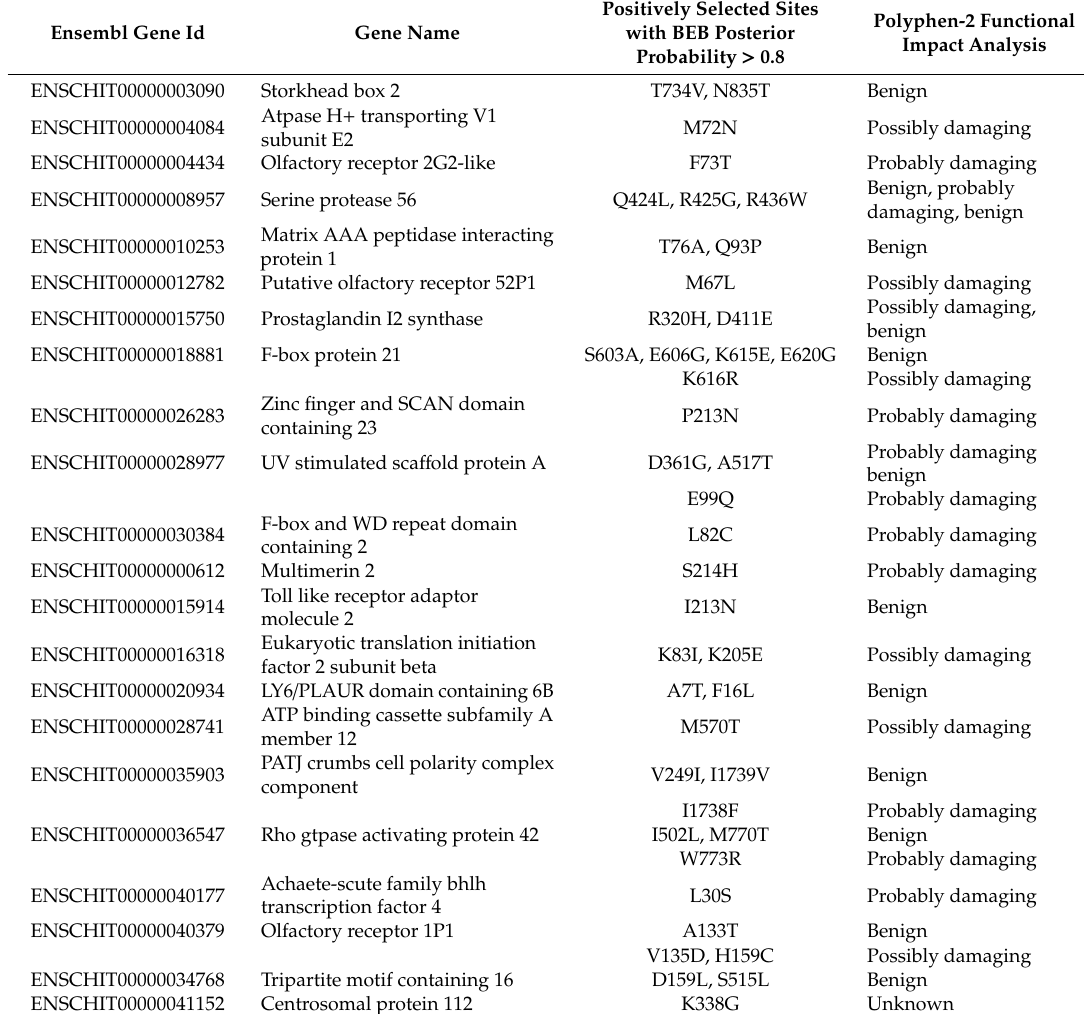
Table 1. Positively selected genes in C . nubiana